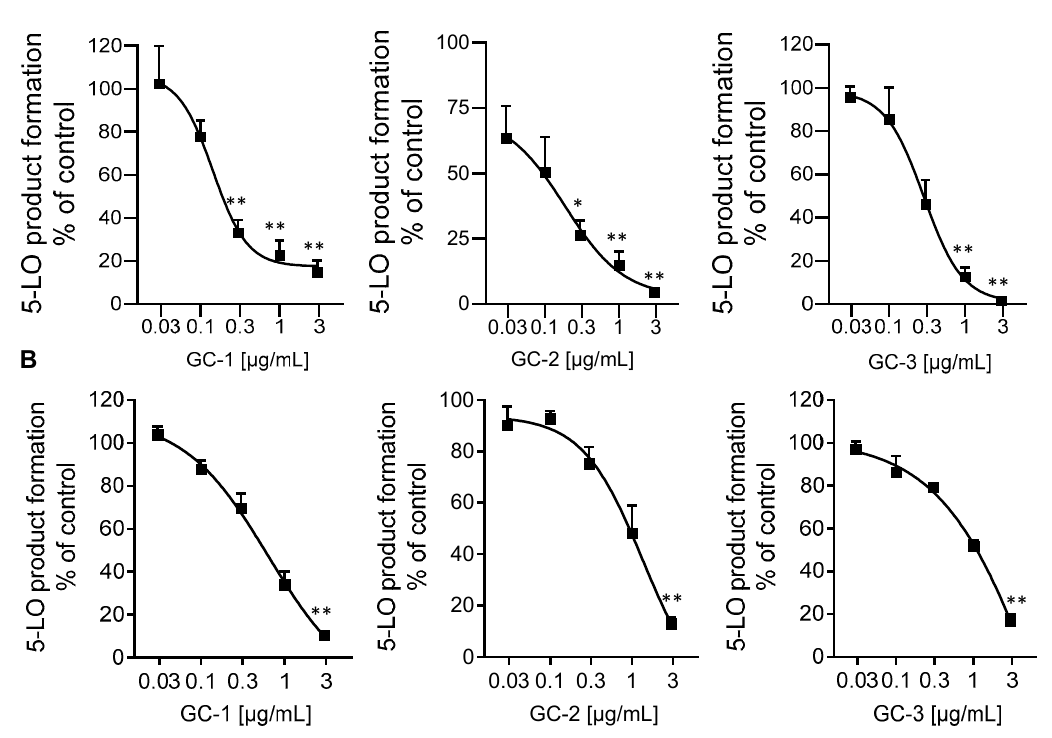
Figure 1. Inhibition of 5-LO in cell-free assays ( A ) and in intact neutrophils ( B ) by extracts of n -hexane (GC-1), DCM (GC-2) and ethyl acetate (GC-3) of G. cambogia . Data are given as means +/ − S.E.M, n = 3. * p < 0.05; ** p < 0.01.